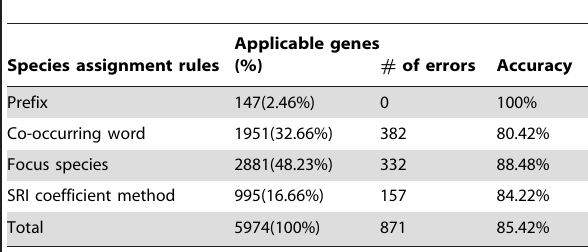
Table 5. Breakdown of errors by different